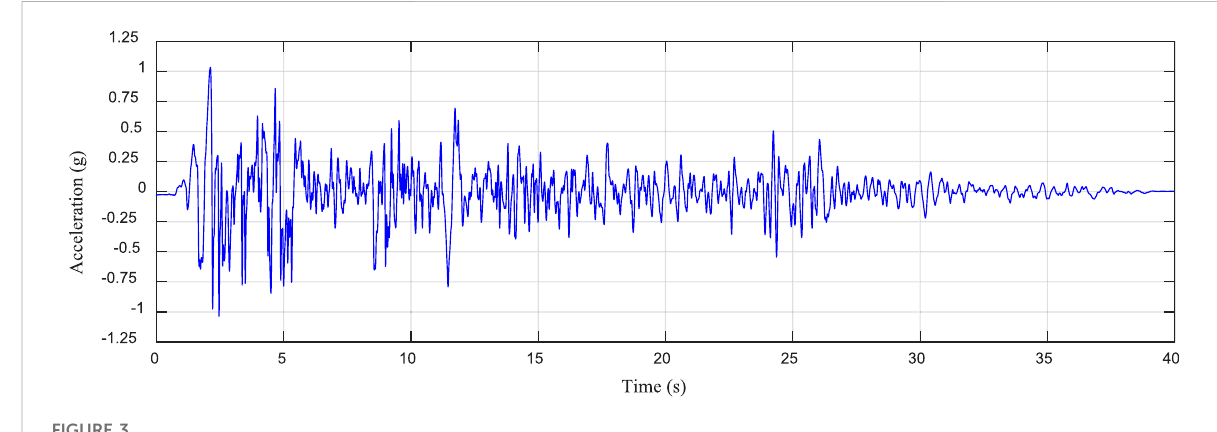
FIGURE 3 Acceleration time history of the selected ground motion